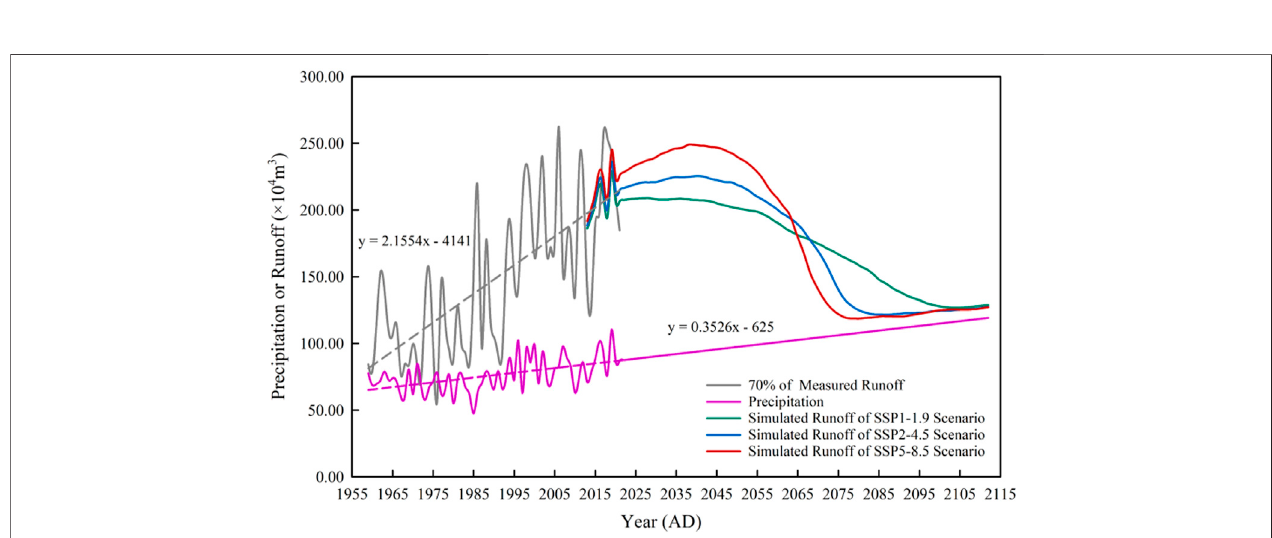
FIGURE 12 | Simulated meltwater of the glacier as a function of time in the three climate scenarios: (A) the meltwater of the entire glacier; (B) the meltwater of the EB; and (C) the meltwater of the WB.